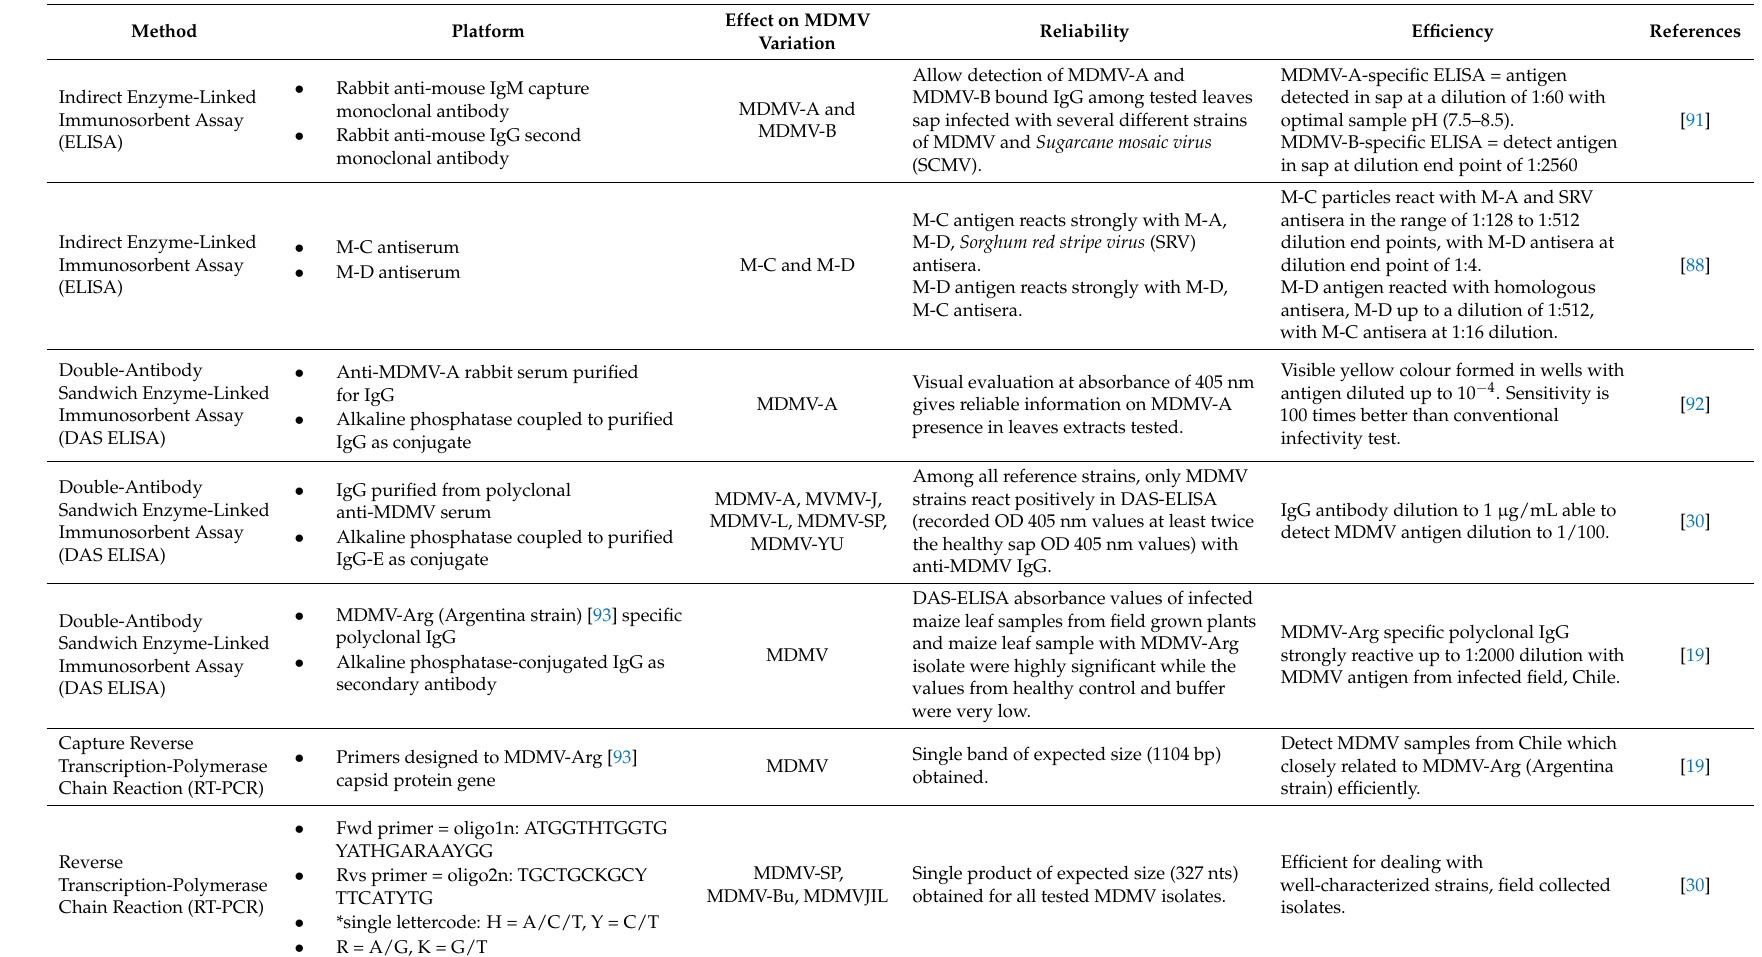
Table 2. Methods for Maize dwarf mosaic virus (MDMV)